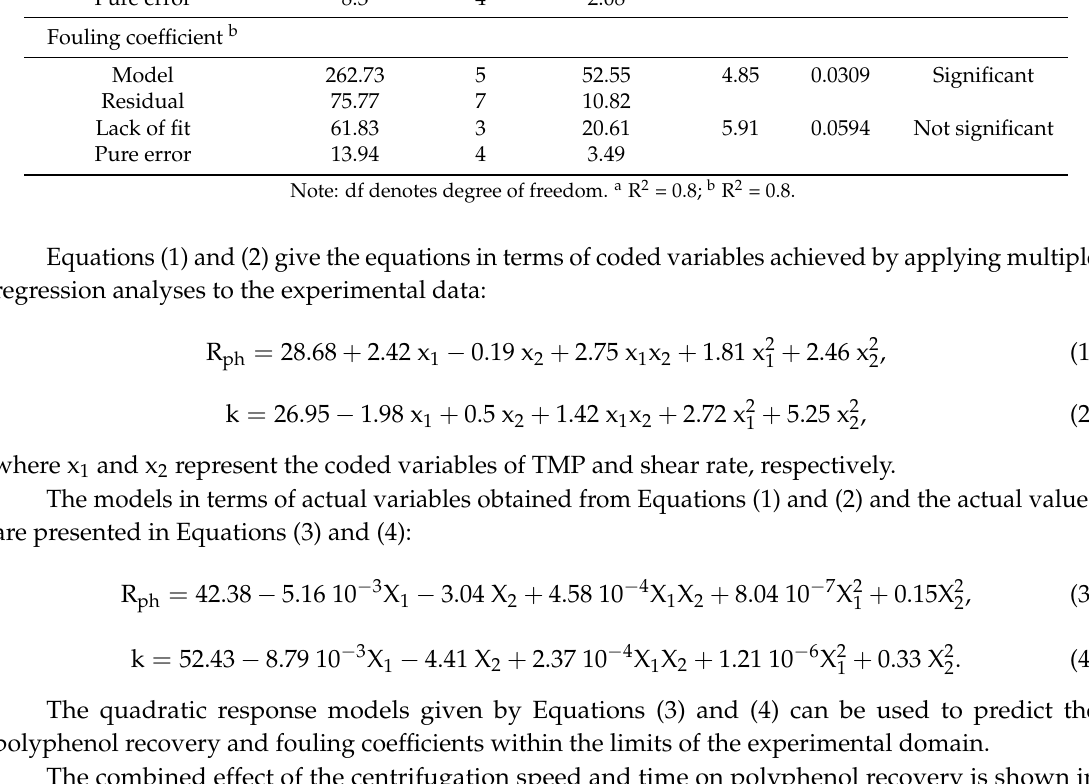
Table 1. Analysis of variance (ANOVA) for the response surface methodology (RSM) models of polyphenol recovery and the fouling coefficient. Source Sum of Squares df Mean Square F -Value p -Value (Prob > F ) Polyphenol recovery a Model 135.09 5 27.02 4.62 0.0349 Significant Residual 40.94 7 5.85 Lack of fit 32.64 3 10.88 5.24 0.0718 Not significant Pure error 8.3 4 2.08 Fouling coefficient b Model 262.73 5 52.55 4.85 0.0309 Significant Residual 75.77 7 10.82 Lack of fit 61.83 3 20.61 5.91 0.0594 Not significant Pure error 13.94 4